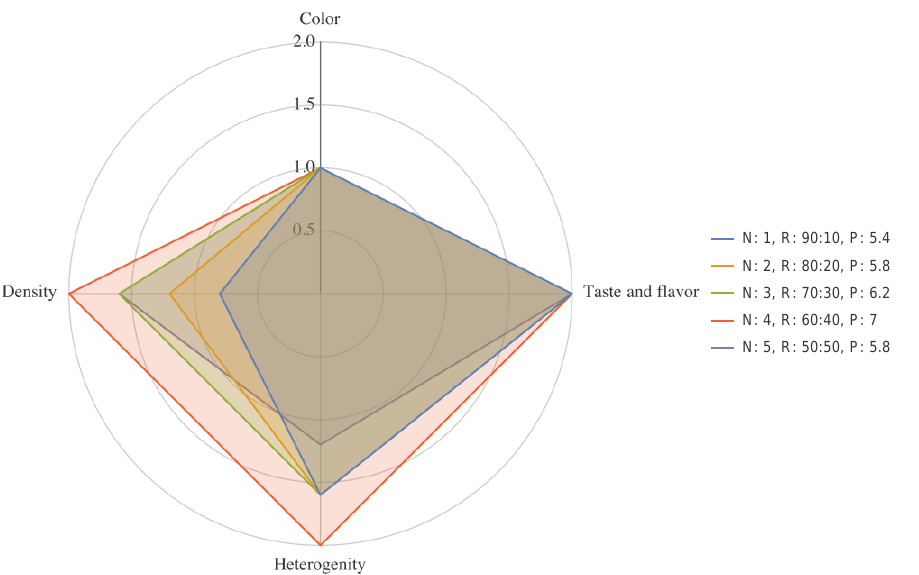
Figure 6. Diagram of the curd product organoleptic properties. N: sample group number, R: curd-to-fermented-dairy-beverage ratio, p : final score, points.